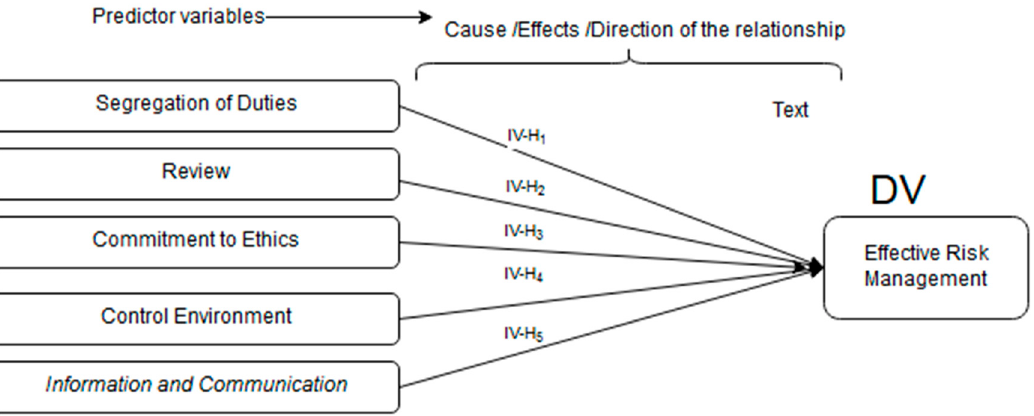
Figure 2. Conceptual framework.